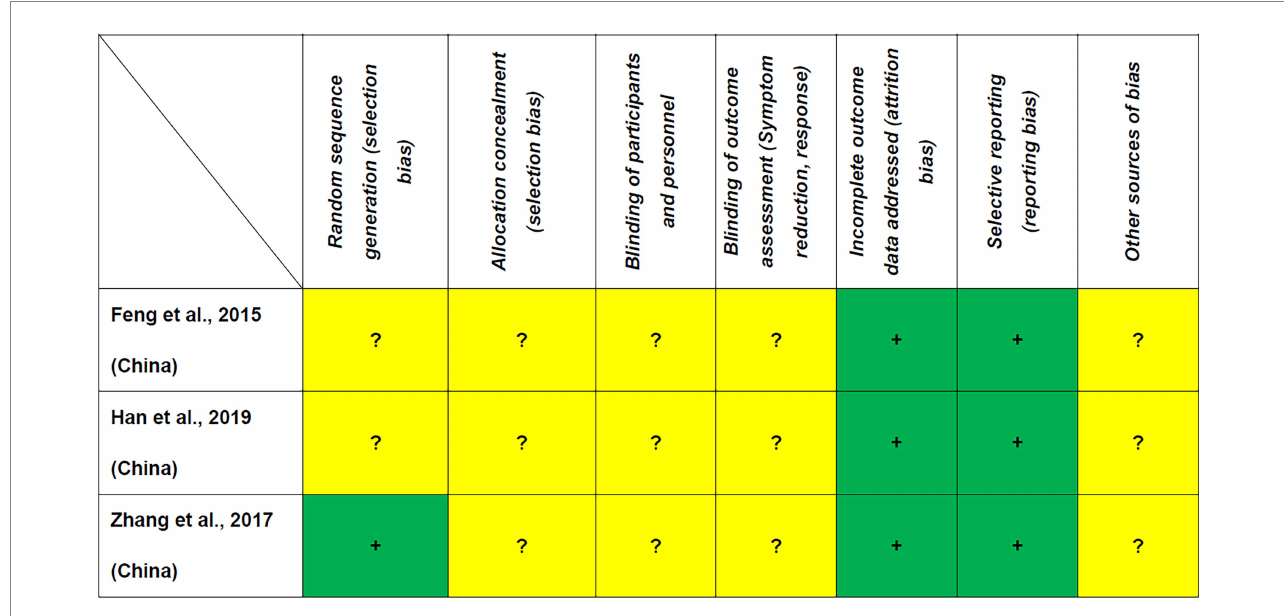
TABLE 2 Active versus sham LF-rTMS for adolescent patients with FEDN depression: study-defined response and remission. Study Treatment Defination Active LF-rTMS outcomes (29) (China)